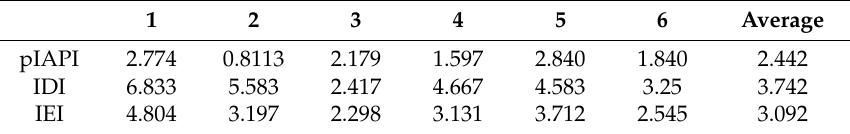
Table 7. Calculated IAQ indexes for university buildings in downtown